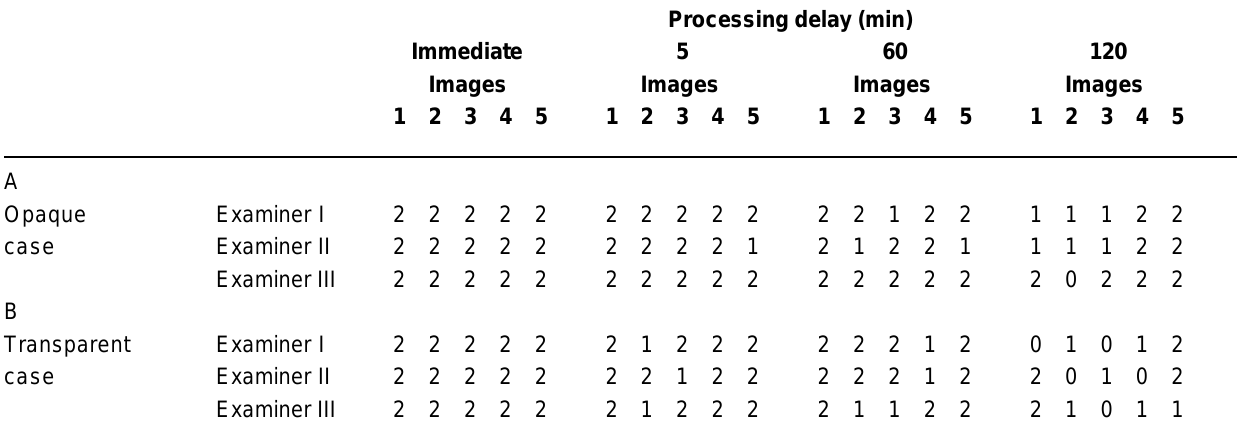
TABLE 1- Scores (0 to 2) assigned to radiographic images (1 to 5) by examiners (I, II and III), according to the type of plastic case (A-opaque and B-transparent) and processing delay (min.)